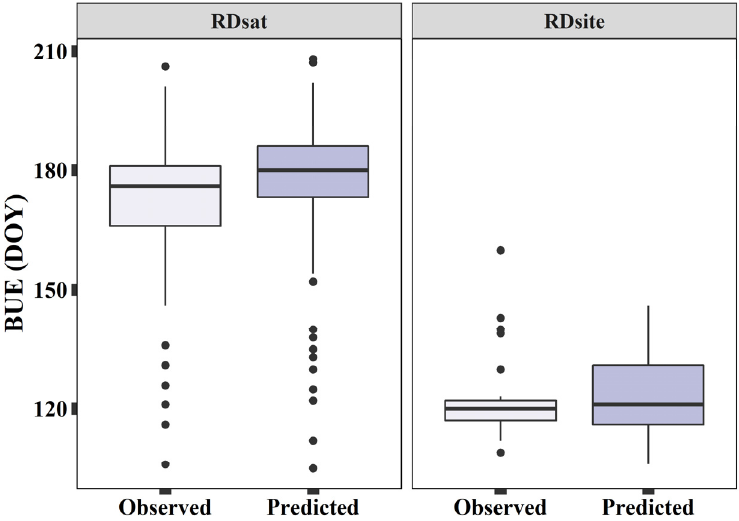
Figure 5. Box plots of the observed and predicted lake ice BUE dates using in situ observations (RDsite) and sample points from satellite visual interpretation (RDsat). Table 2. Error metrics of the predicted BUE results using RDsite and RDsat (unit: day). Number